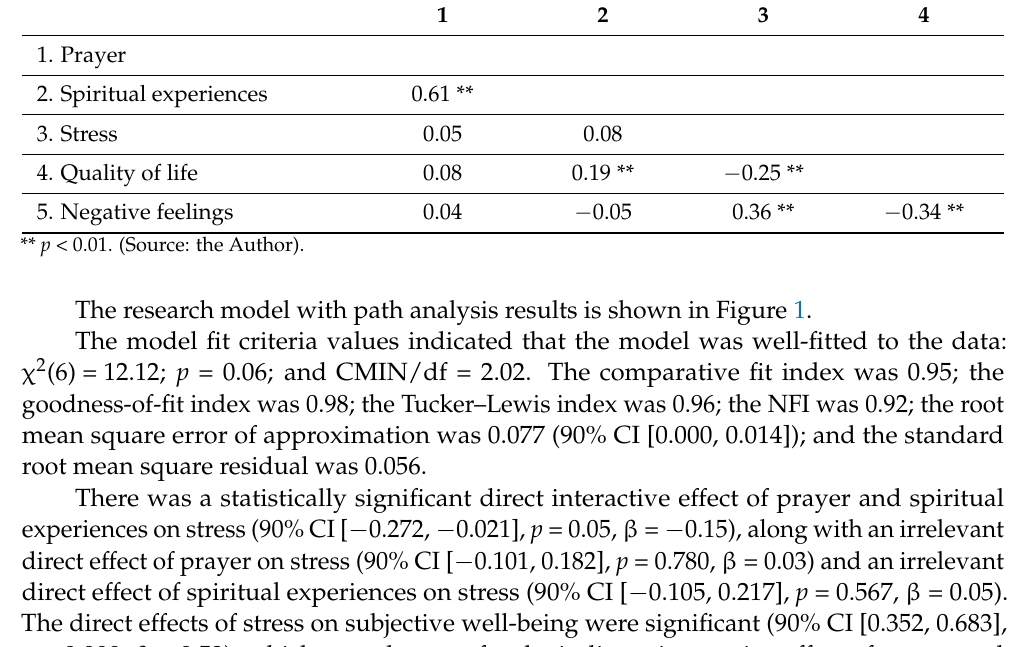
Table 2. Pearson’s correlation coefficients in a sample of Chilean students ( n = 177).